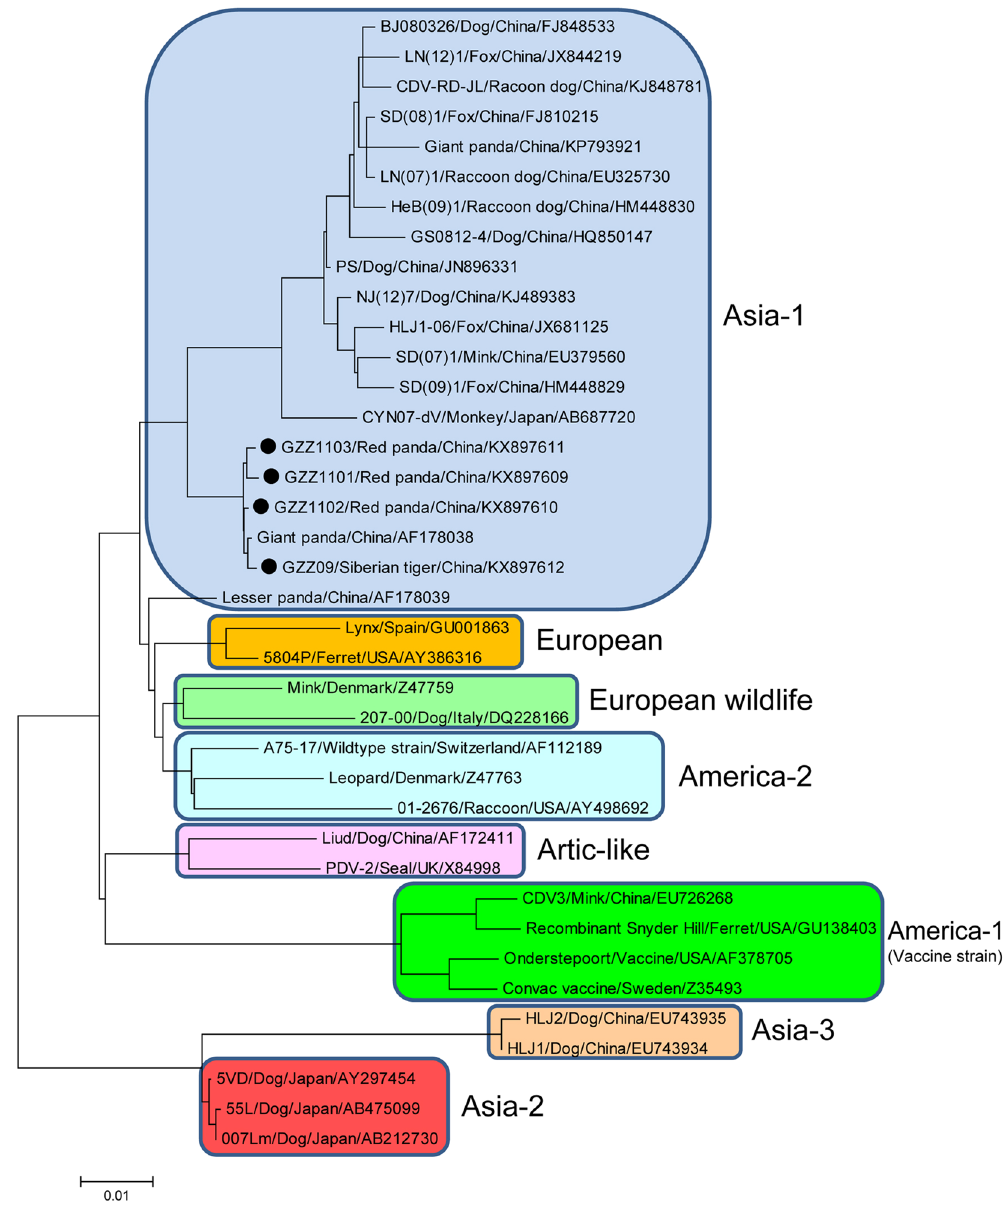
Figure 1. Phylogenetic analysis based on H gene sequences of different genotypes of CDVs. Note: The CDV strains in this study were marked with “ •